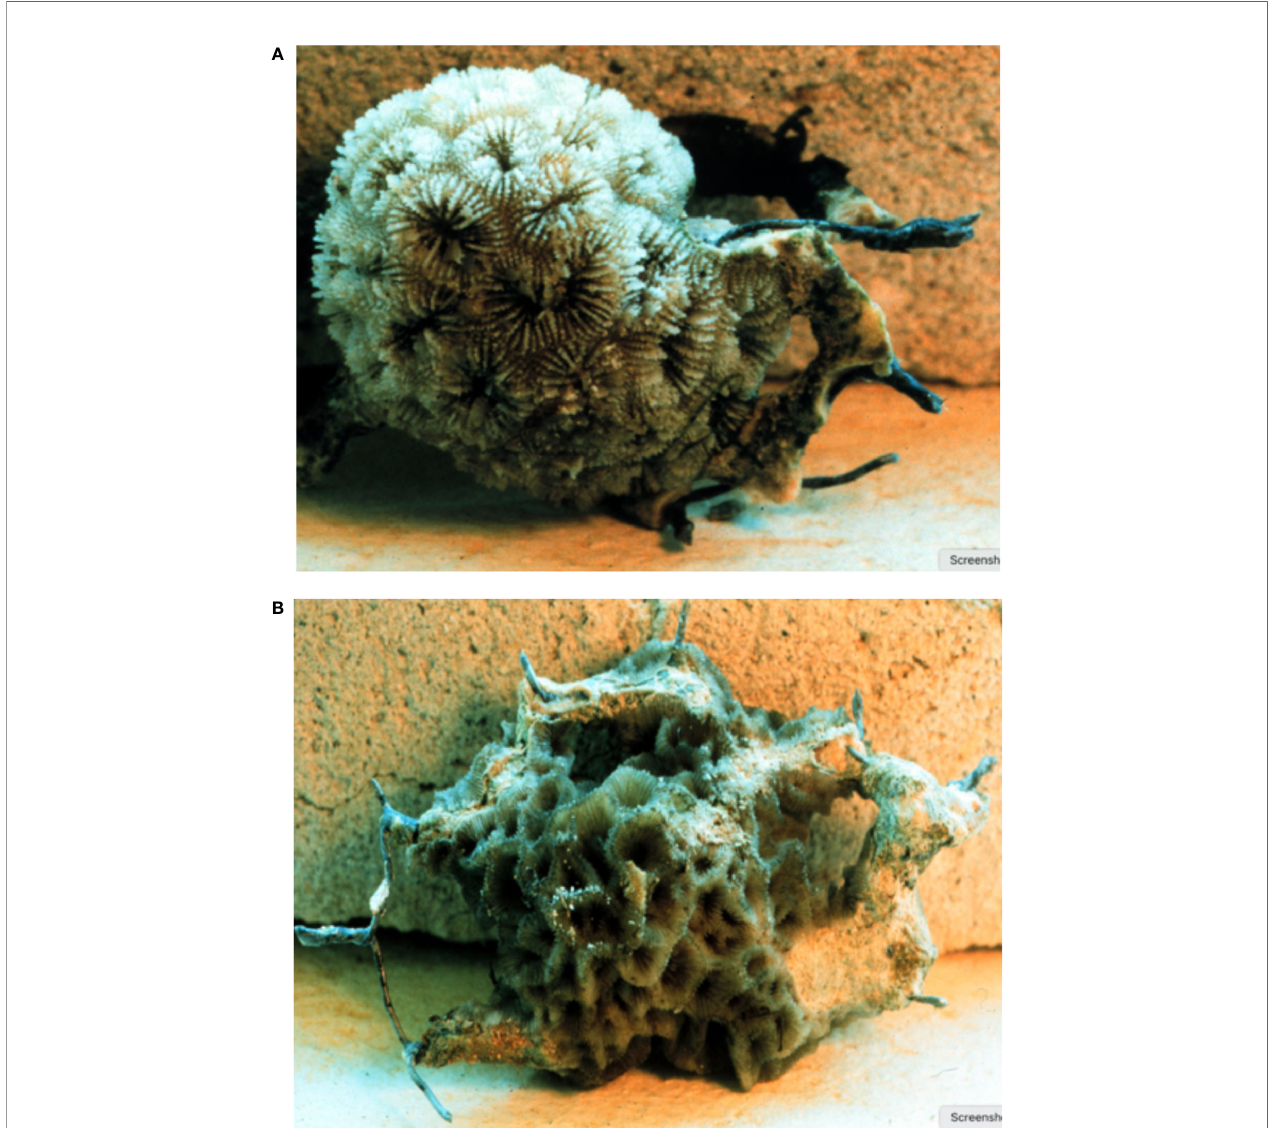
FIGURE 6 | (A, B) Favia fragum (above) and Agaricia agaricites (below) spontaneously settle on one inch chicken wire mesh, about 1-2 years old. Photographs by T. J. F. Goreau, 1990, Discovery Bay,